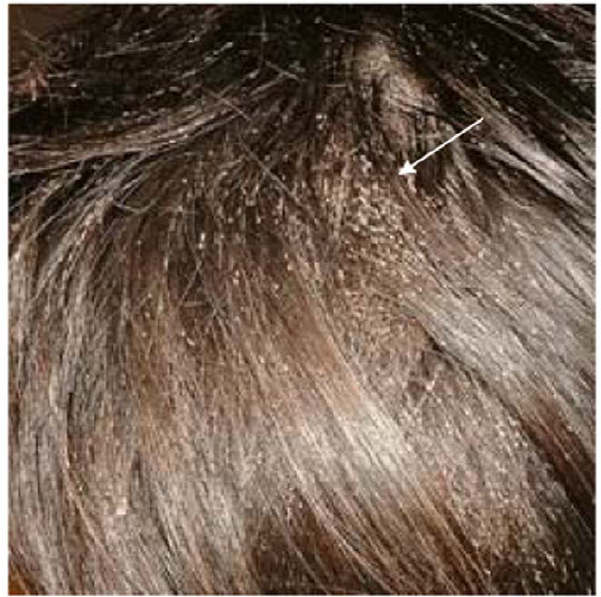
Figure 4. Heavily infested hair with Pediculushumanuscapitis (arrow). The patient gave informed consent for use of this